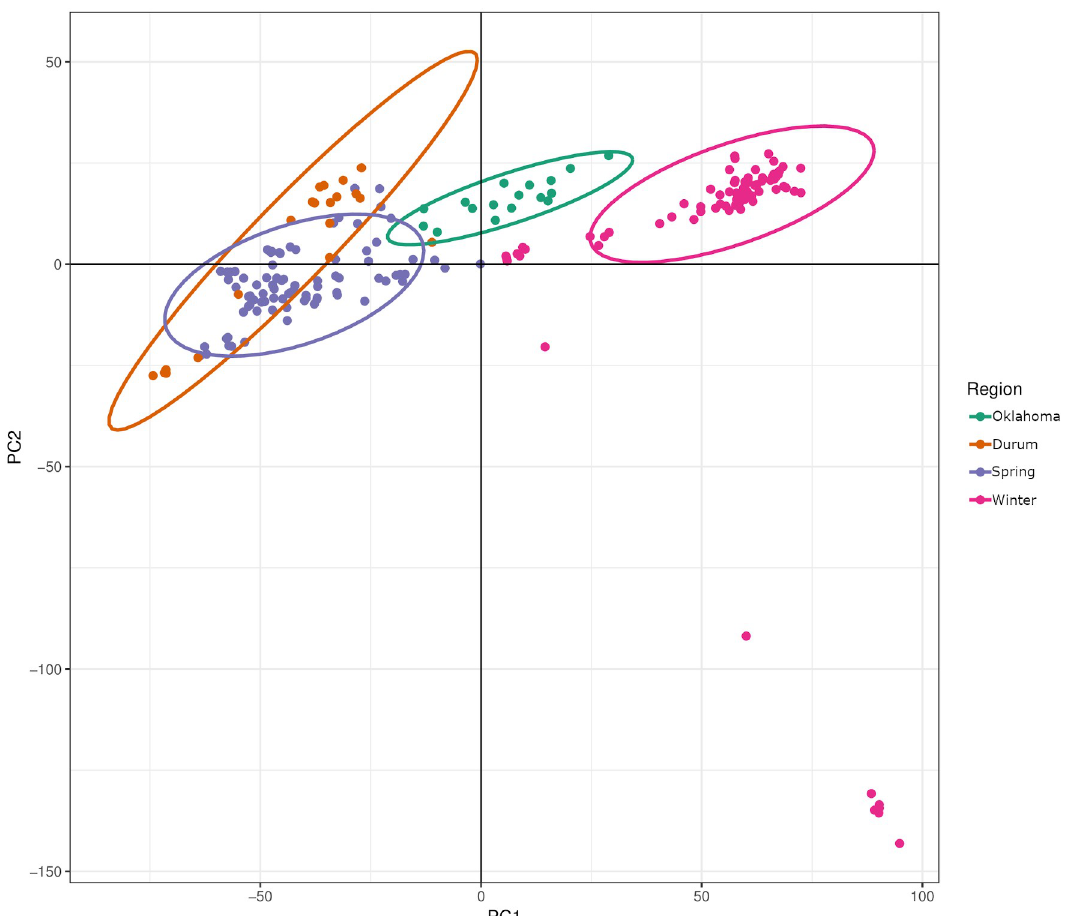
Fig 1. PCA using genotypic data of 50,000 randomly selected markers. PC1 is represented on the x-axis and PC2 is represented on the y-axis. Colored dots correspond to individual isolates and the color signifies the predominant wheat class (or state) of the region from which the isolate was collected. The isolates collected in Oregon are depicted in the lower right of the figure. The color legend is displayed on the right side of the figure.